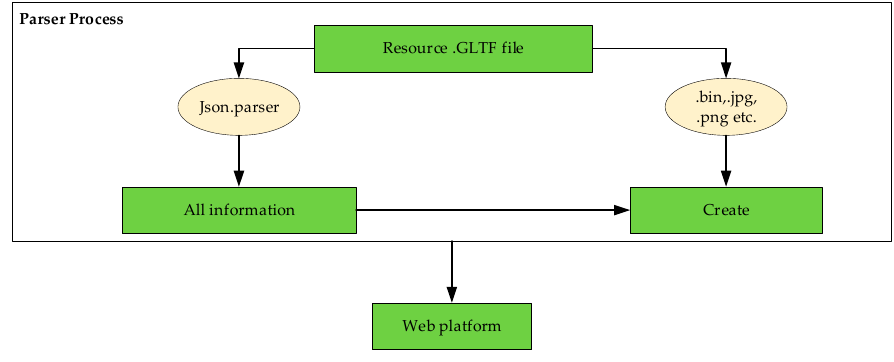
Figure 11. GLTF file parsing process.